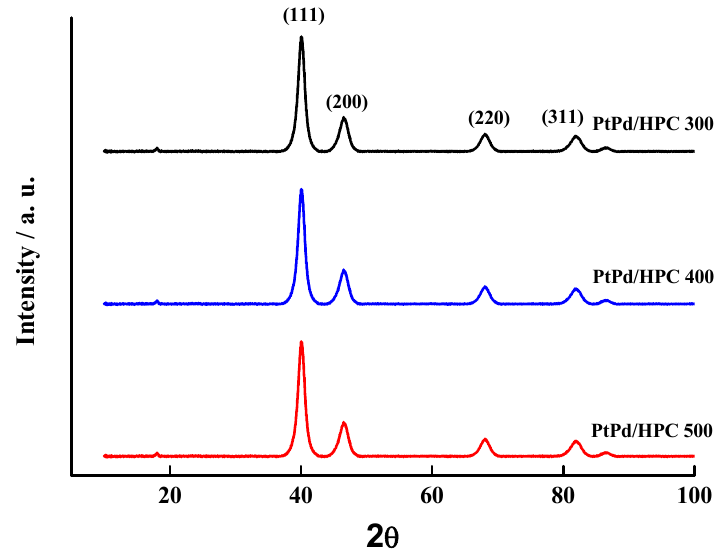
Figure 2. XRD diffractograms of PtPd/HPC samples.